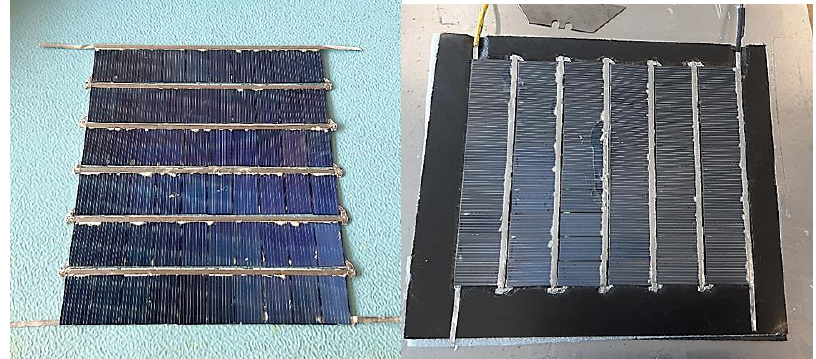
Figure 10. Small-sized demonstrators produced for mechano-climatic testing.